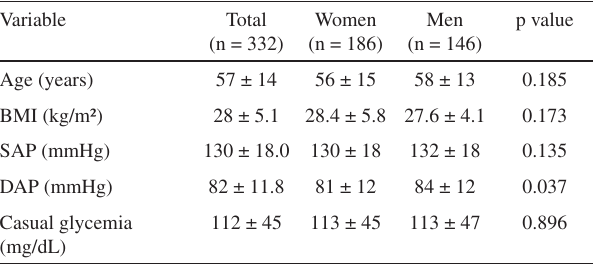
Table 1 - Comparison of clinical variables between women and men in the study